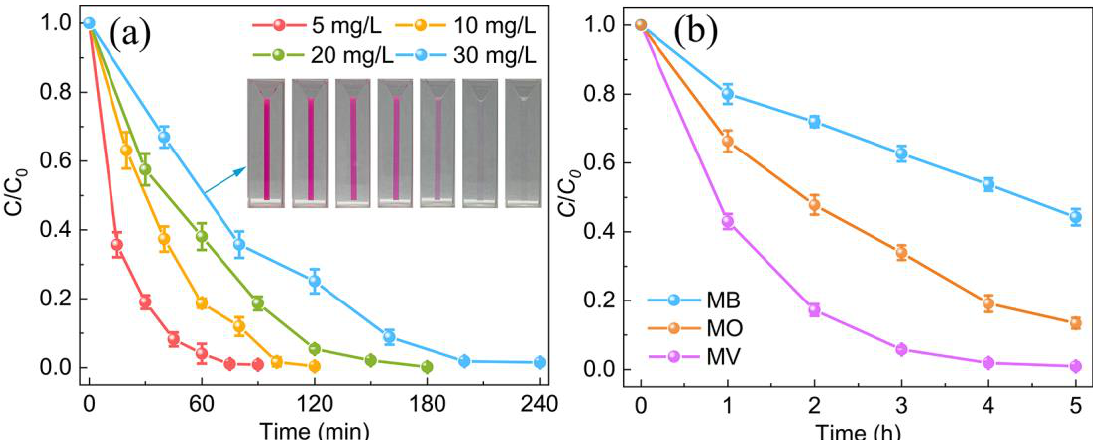
Figure 4. ( a ) Tribocatalytic degradation efficiency of RhB with different concentrations (5 – 30 mg L −1 ) by ZnO-3 (Inset: The optical photos of the RhB solution (30 mg L −1 ) from 0 to 240 min); ( b ) catalytic efficiencies of degradation of MB (10 mg L −1 ), MO (10 mg L −1 ), and MV (10 mg L −1 ), separately.